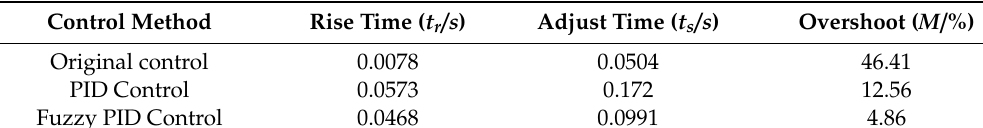
Figure 7. Fuzzy PID control Simulink simulation results. Table 5. Fuzzy PID control simulation data.